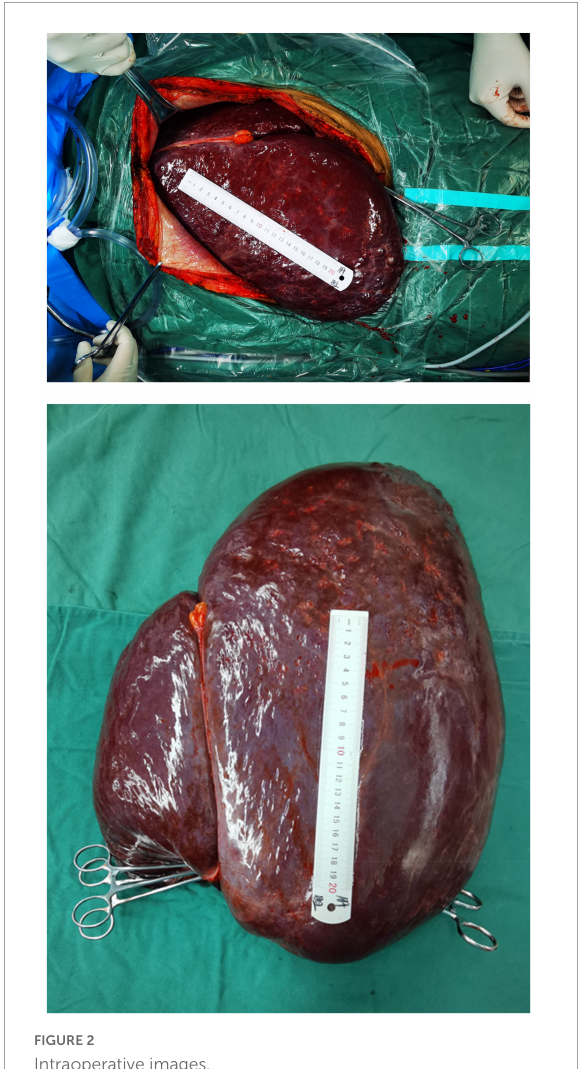
FIGURE2 Intraoperative